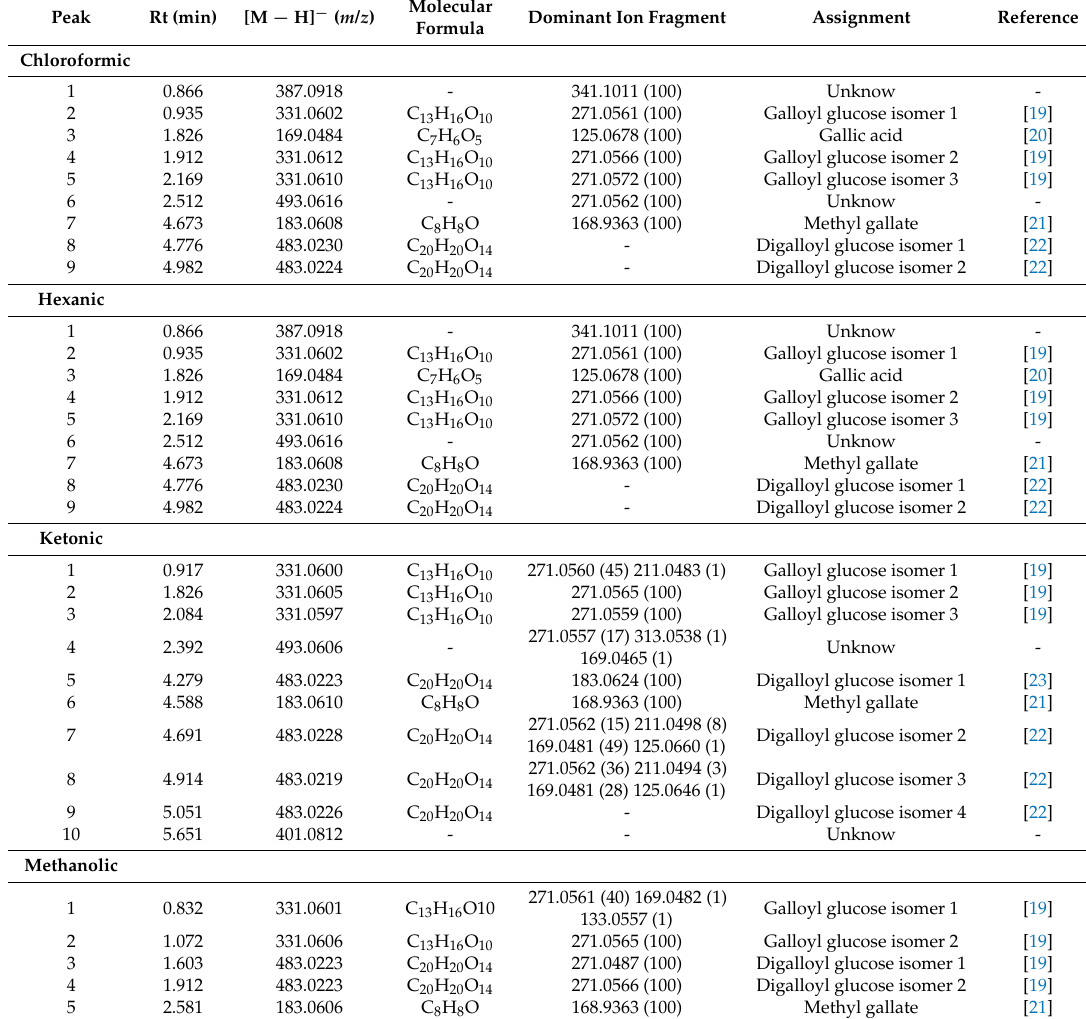
Table 1. Compounds identified in six extracts from Acacia farnesiana (AF)